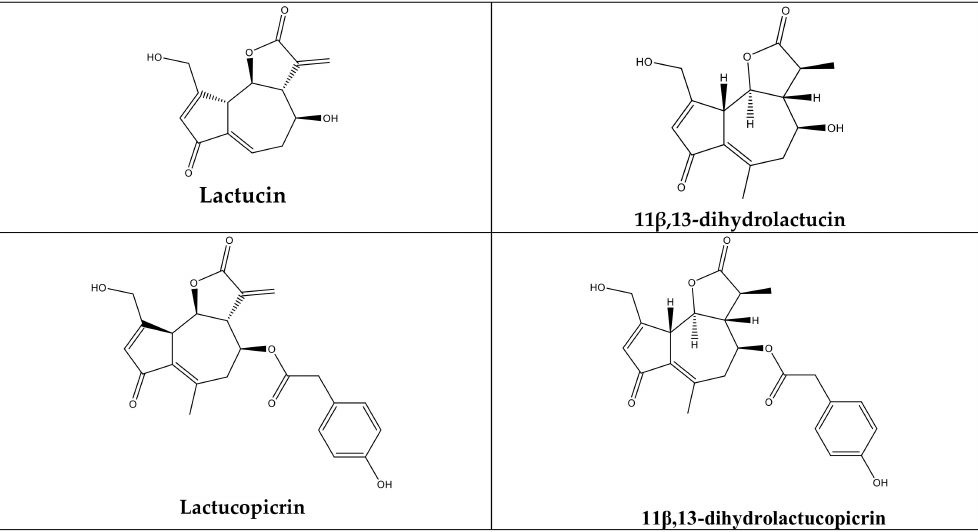
Figure 2. Molecular formulas of the sesquiterpene